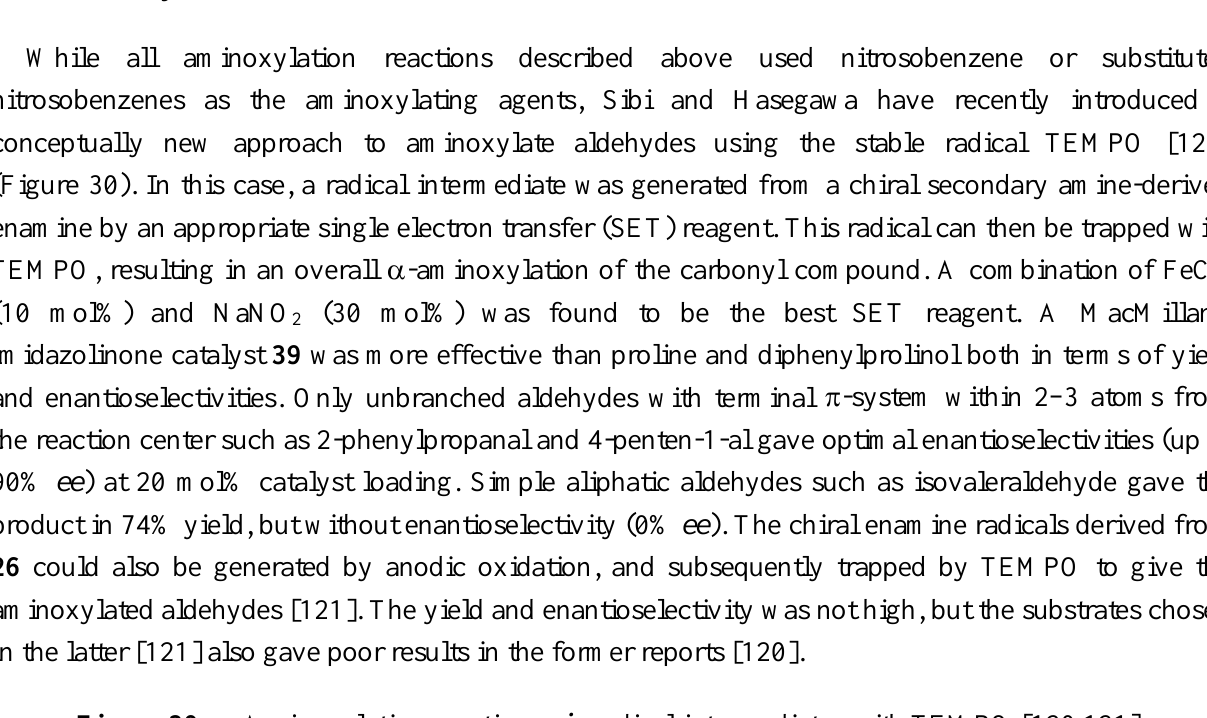
Figure 30.  -Aminoxylation reactions via radical intermediates with TEMPO